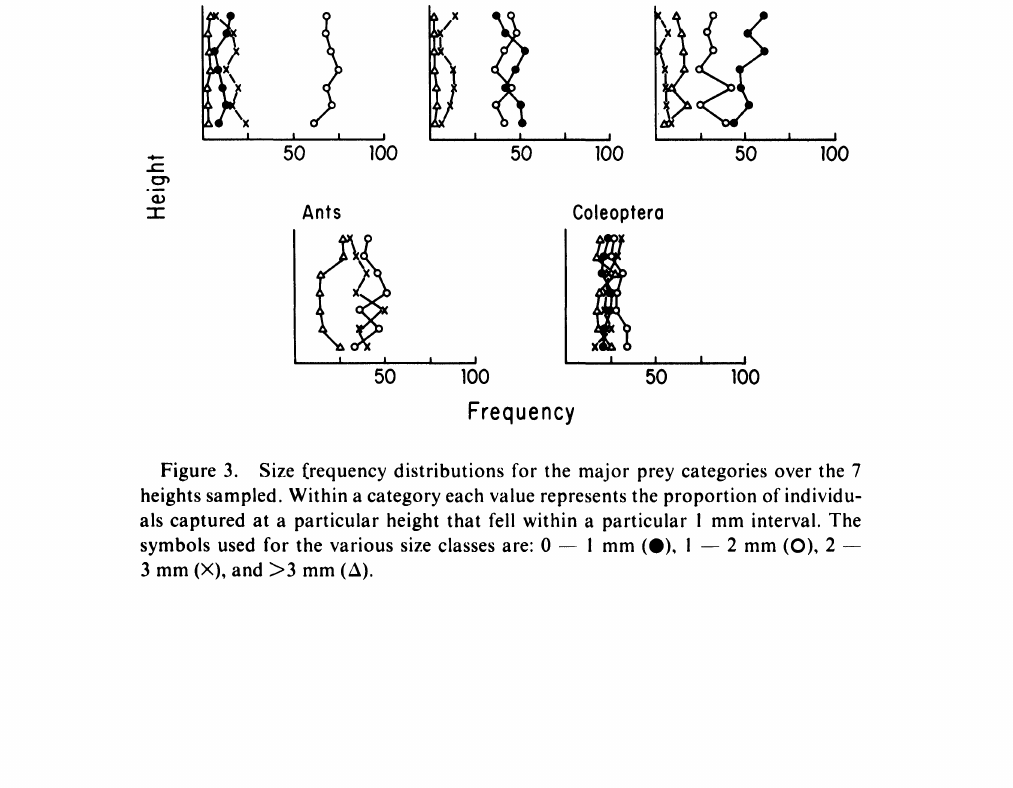
Figure 2. Relative abundances of major prey categories over all heights sampled. Each value represents a proportion of the total number of individuals captured on 10 sticky traps suspended at a particular height. See text for details of sampling method.